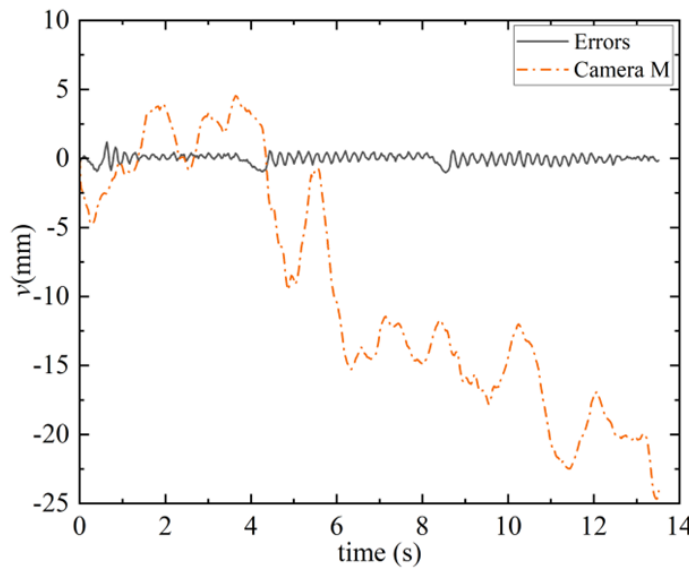
Figure 14. Errors and displacement of camera M.